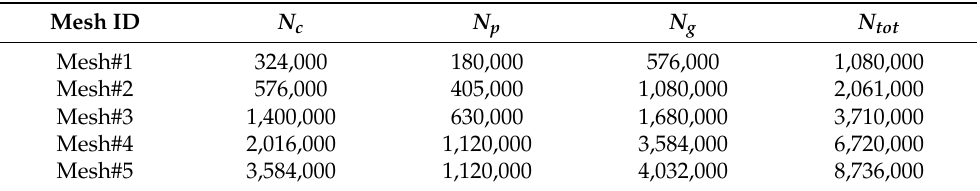
Table 2. Grid division of different meshes.